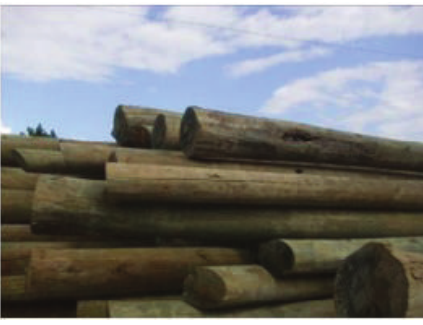
Figure 8: Preboring holes were not made before the